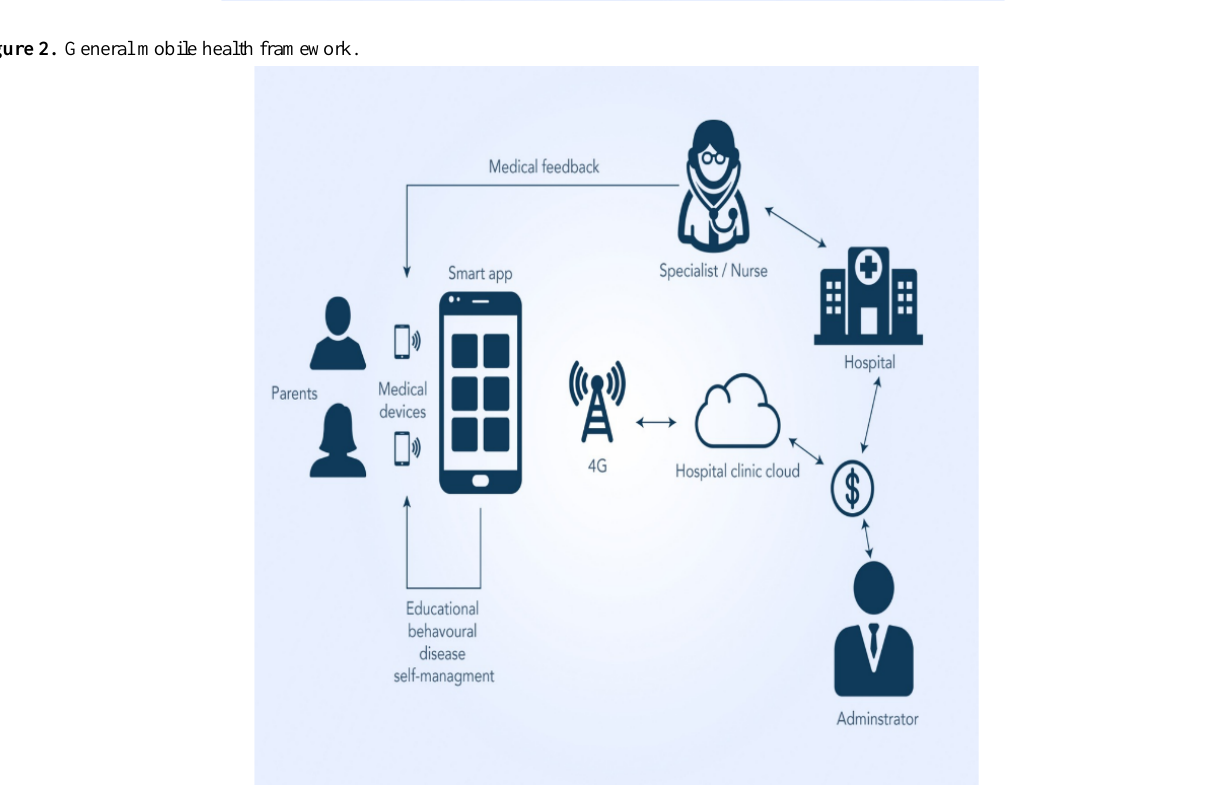
Figure 2. General mobile health